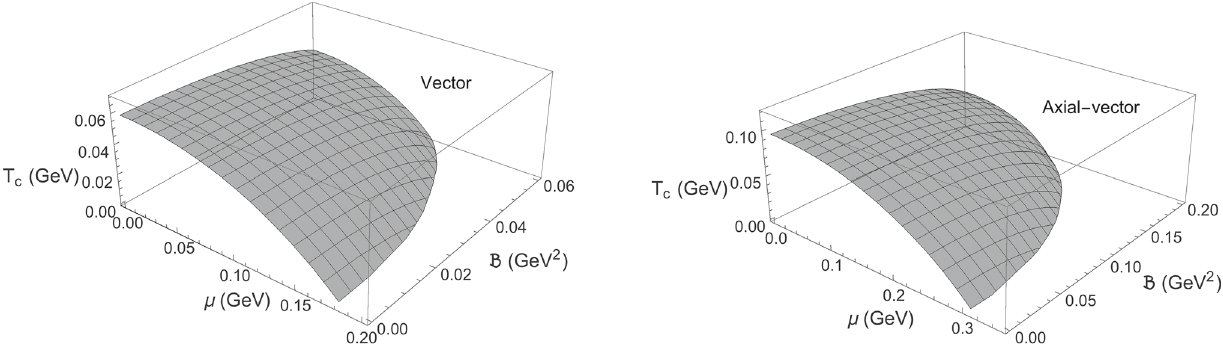
Fig. 8 The phase diagrams for the melting of vector meson (left panel) and axial-vector meson (right